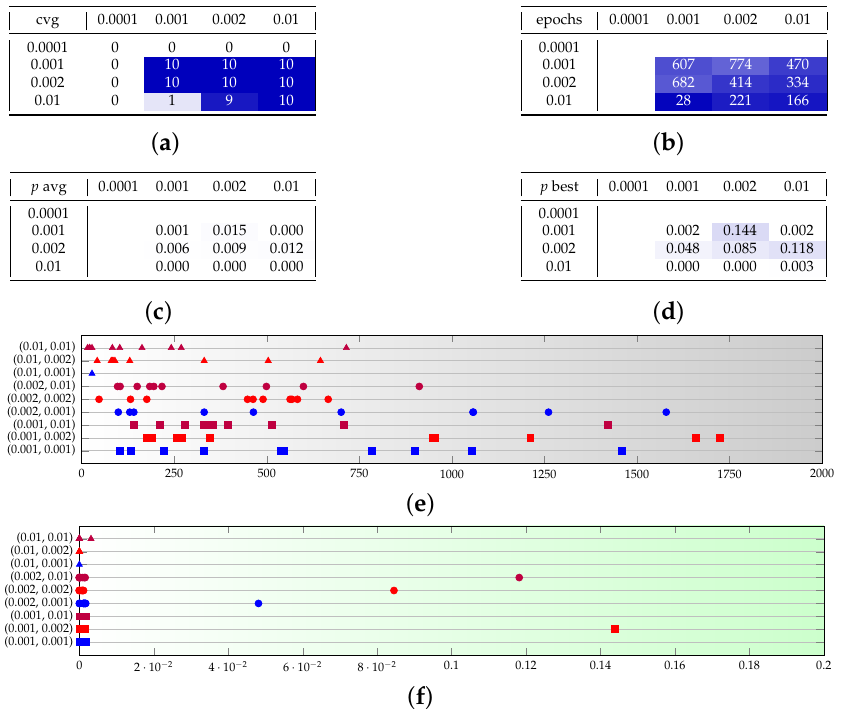
Figure A12. Test set K provides a sensitivity analysis on the learning rates for Adam, n = 4 qubits. ( a – d ) The rows represent the generator learning rate, and the columns represent the discriminator learning rate. ( e , f ) The couples on the vertical axis are ( lr gen ,lr discr ) . The marker shapes represent lr gen and marker colors represent lr discr . ( a ) Converging runs, out of 10. ( b ) Number of epochs before convergence, on average. ( c ) p -value for the χ 2 test once convergence is reached (average over converging runs). ( d ) p -value for the χ 2 test once convergence is reached (best run). ( e ) Visual representation of the epochs before convergence. ( f ) Visual representation of the p -value, zoomed on 0.2, as no points have p > 2. p ≤